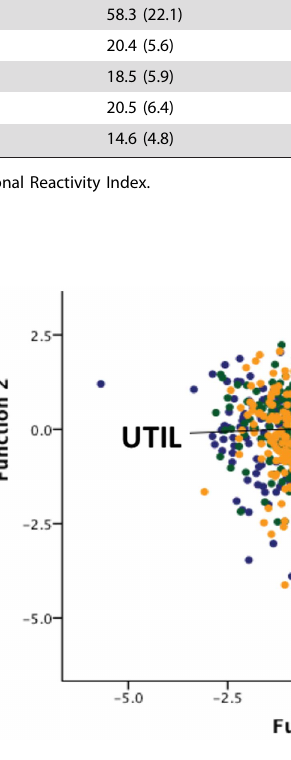
Figure 3. Distribution of UTIL (blue), DEON (orange), and MAJORITY (green) participants with regards to the two functions generated by discriminatory analysis. Red squares represent group centroids and reveal that UTIL participants are